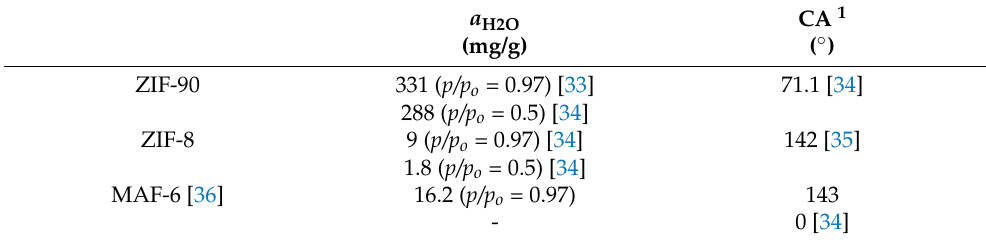
Table 2. Hydrophobic/hydrophilic properties of